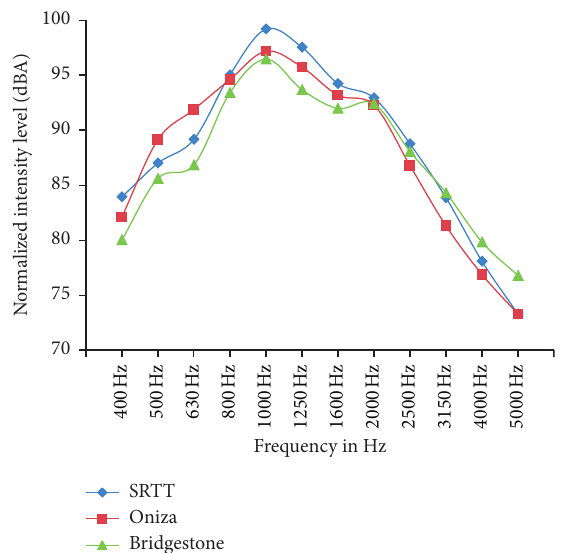
Figure 13: Frequency response of tested tires for Section 1.